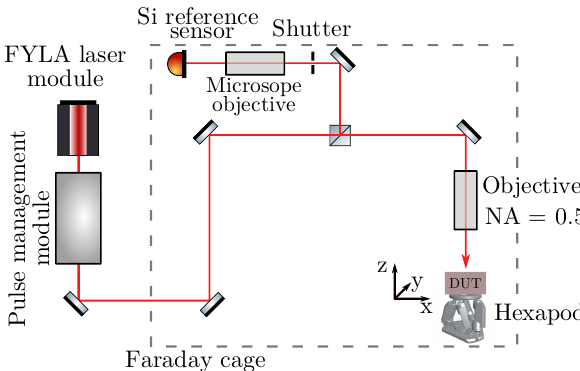
Figure 1. Schematic drawing of the used TPA-TCT setup.